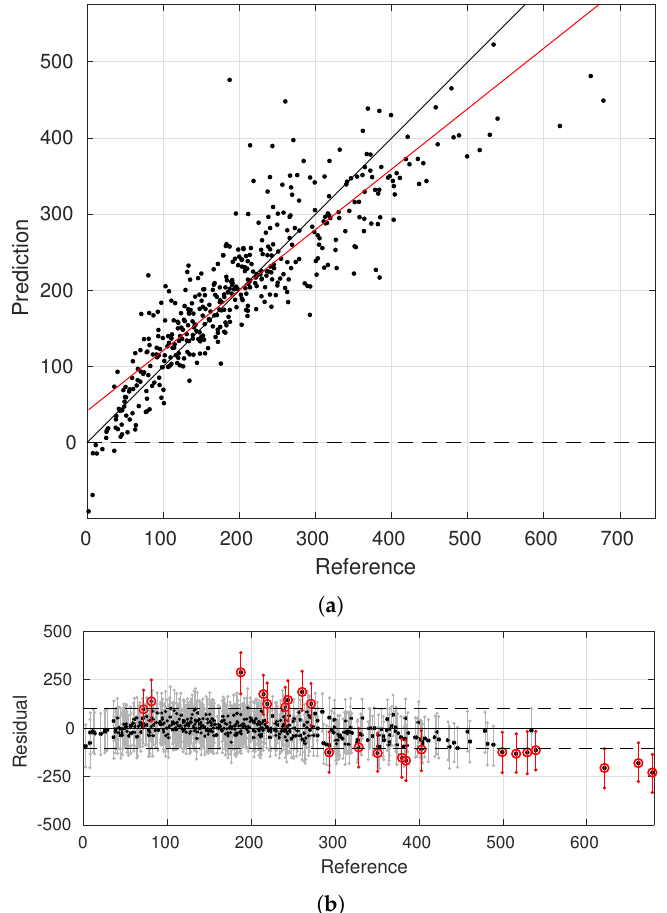
Figure 1. Panel 1a : Predictions of volume [m 3 /ha] versus the reference set (truth), 1:1 line in black, linear fit between predictions and reference values in red. Panel 1b : The residuals of the predictions with black dots, 95% probability intervals with the truth within the interval in gray, the truth outside the interval in red, and the range of 95% probability interval of the predicted values ( ∼± 1.96 · root mean square error) with dashed